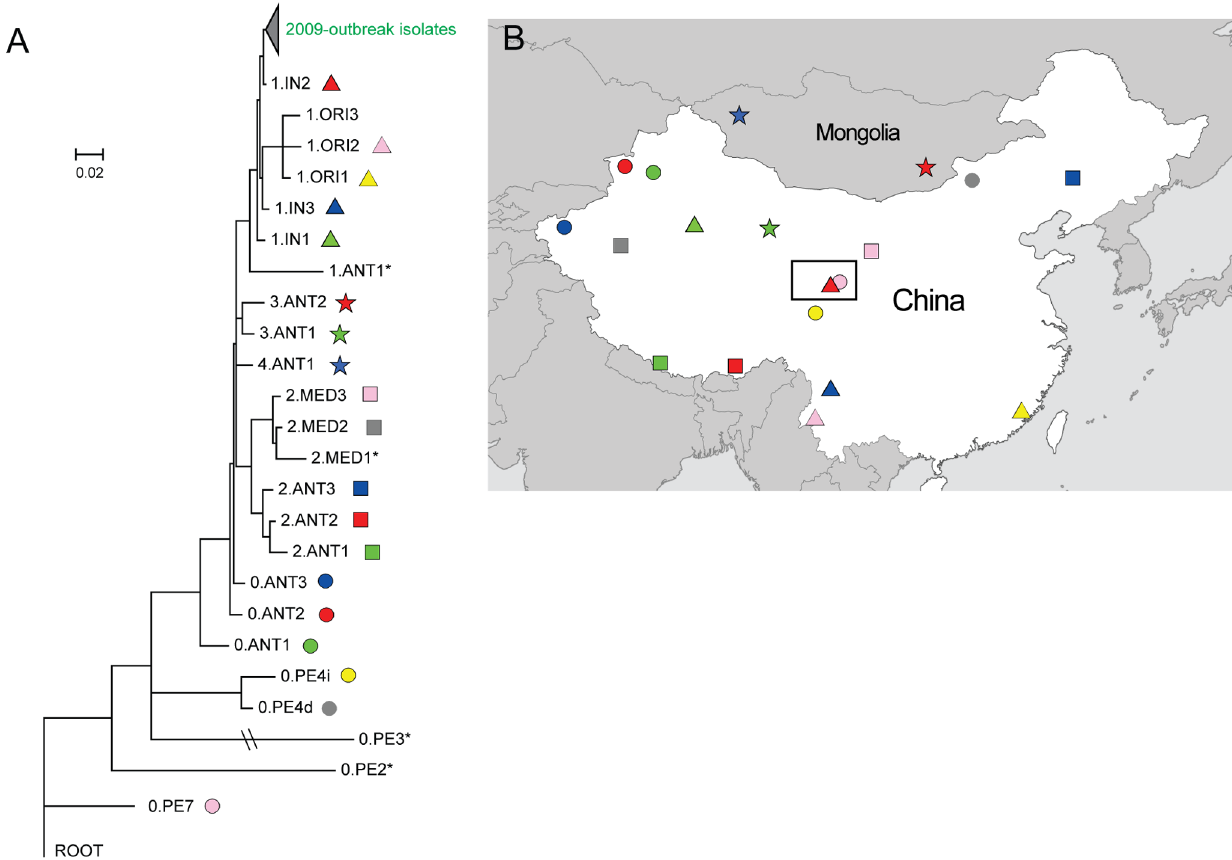
Figure 2. First step of source tracing: defining the phylogenetic position of outbreak strains. (A) MLTree of 2009 outbreak strains and 24 representative Y. pestis strains with global diversity. The branch length reveals genetic distance between isolates, except for the branch of 0.PE3, which was truncated for visual effect. The root was defined by the ancestor Y. pseudotuberculosis , IP32953. Each strain is labeled with different symbols and colors that correspond to its geographical distribution on the map in panel B. Strains that are not mapped in panel B are labeled with an asterisk. As no variations exist across outbreak strains, the corresponding branches were collapsed in the tree. All nodes have a bootstrap support of more than 90%. (B) Geographic information of the strains in the MLTree.